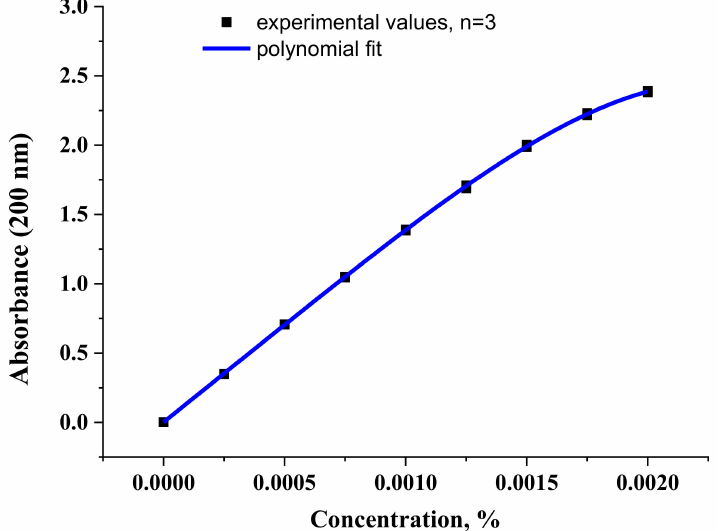
Figure 11. The concentration dependence of the optical density value of diclofenac sodium aqueous solution at a wavelength of 200 nm. The values obtained in the experiment and fitting with a polynomial of the 4th degree are